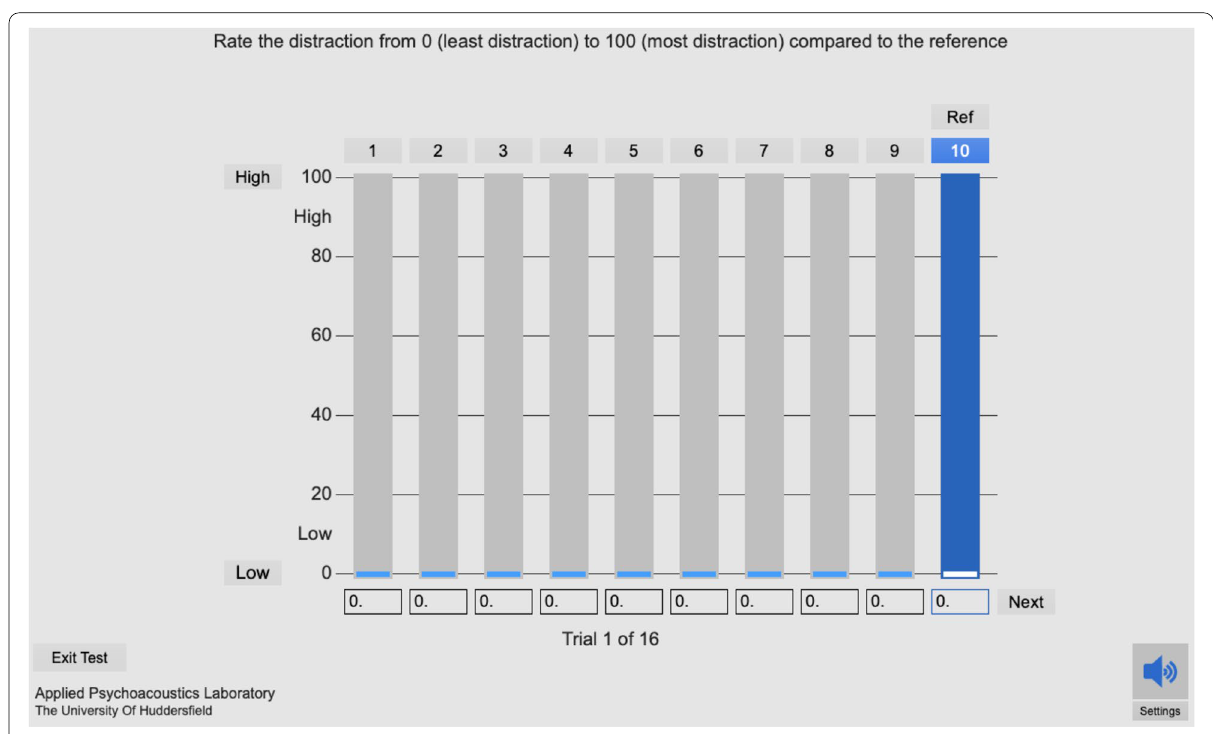
Fig. 2 Interface for the MUSHRA based grading of stimuli presented to listeners [47, 48]